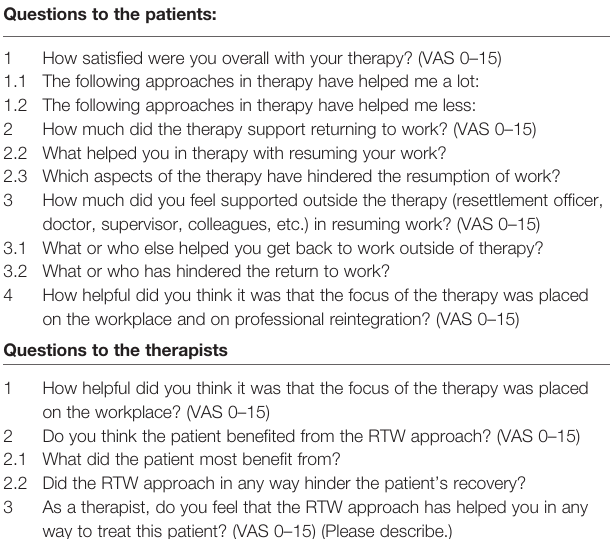
TABLE 2 | List of qualitative questions addressed to the patients and therapists. Questions to the patients: